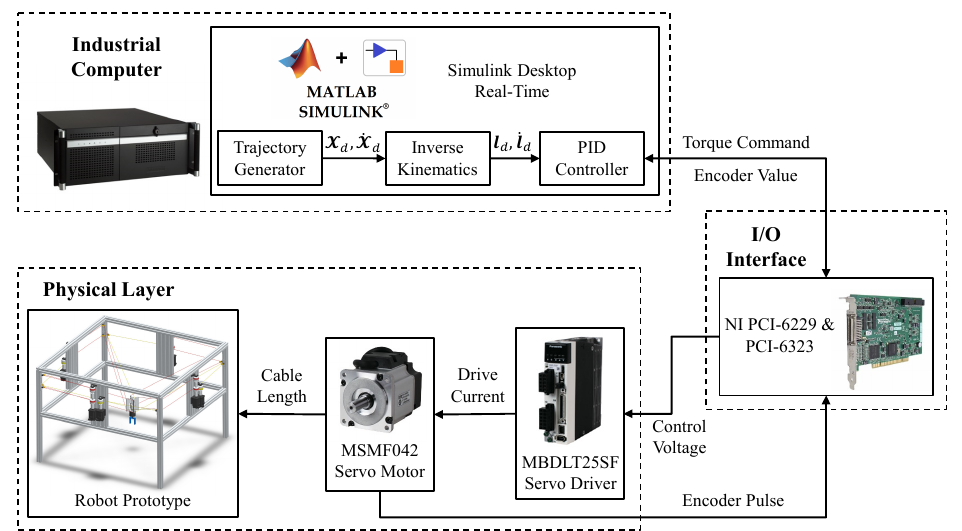
Figure 7. Control system diagram of the robot